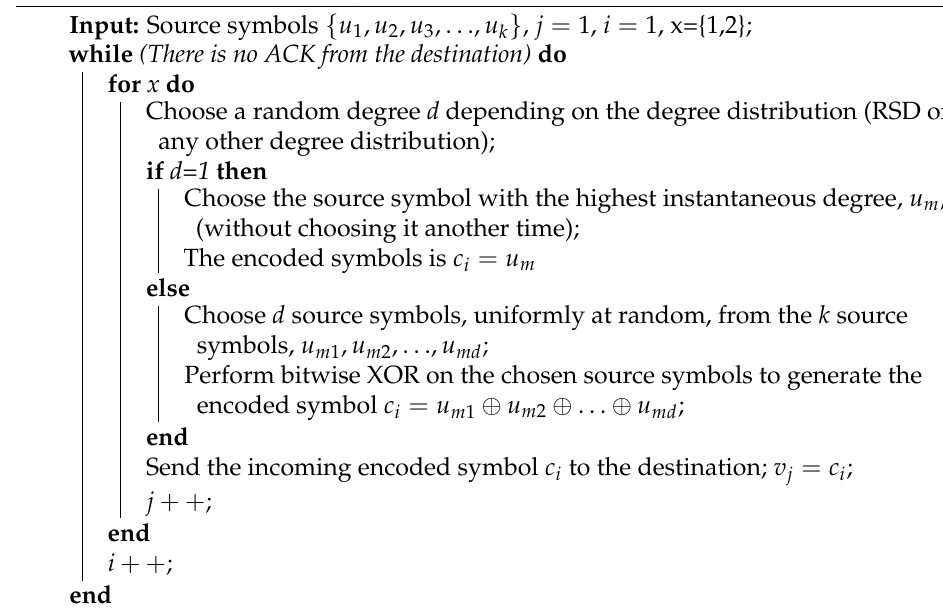
Algorithm 3: MBLT encoding process at the